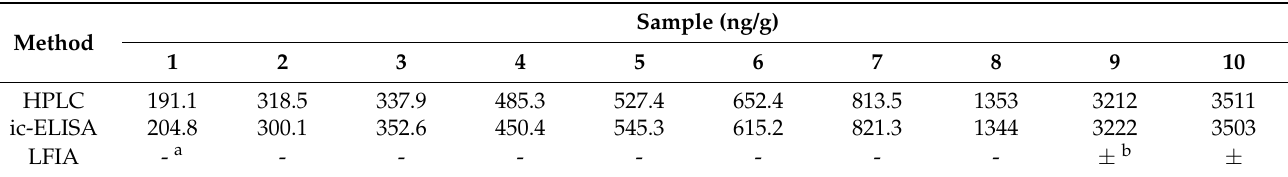
Table 3. The real sample analysis by HPLC, ic-ELISA and LFIA ( n =